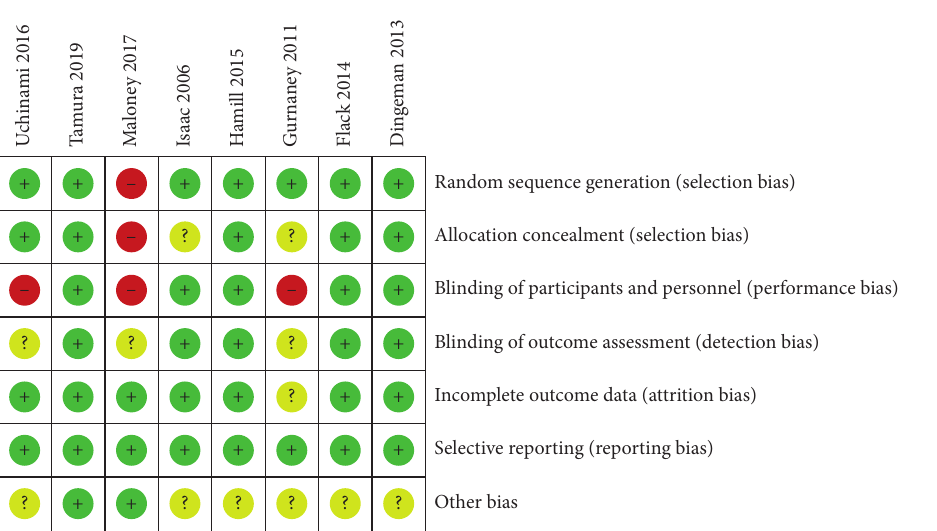
Figure 2: Evaluation summary of bias risk items for each included study. The green, red, and yellow circles represent low, high, and unclear risk of bias,